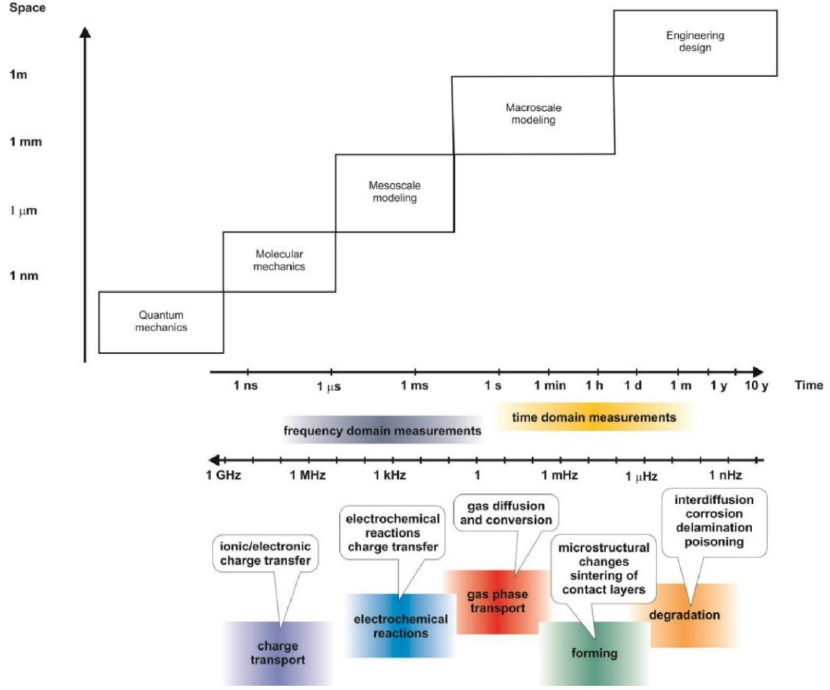
Figure 2. Time, frequency and length scales for the phenomena underpinning SOFC modelling. It should be stated that two diversified approaches may be used in modelling FCs.